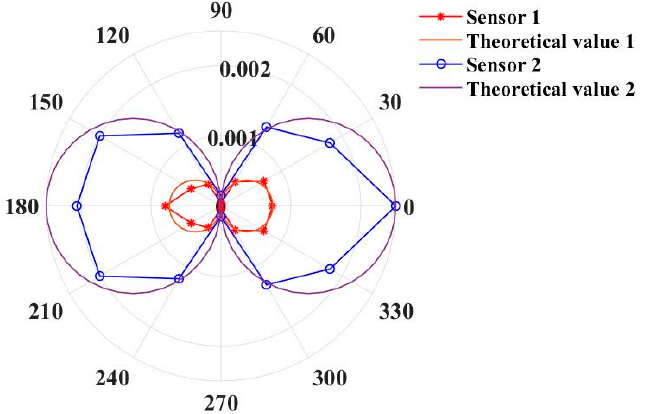
Figure 11. The directivity test results of optical fiber magnetic field sensors.